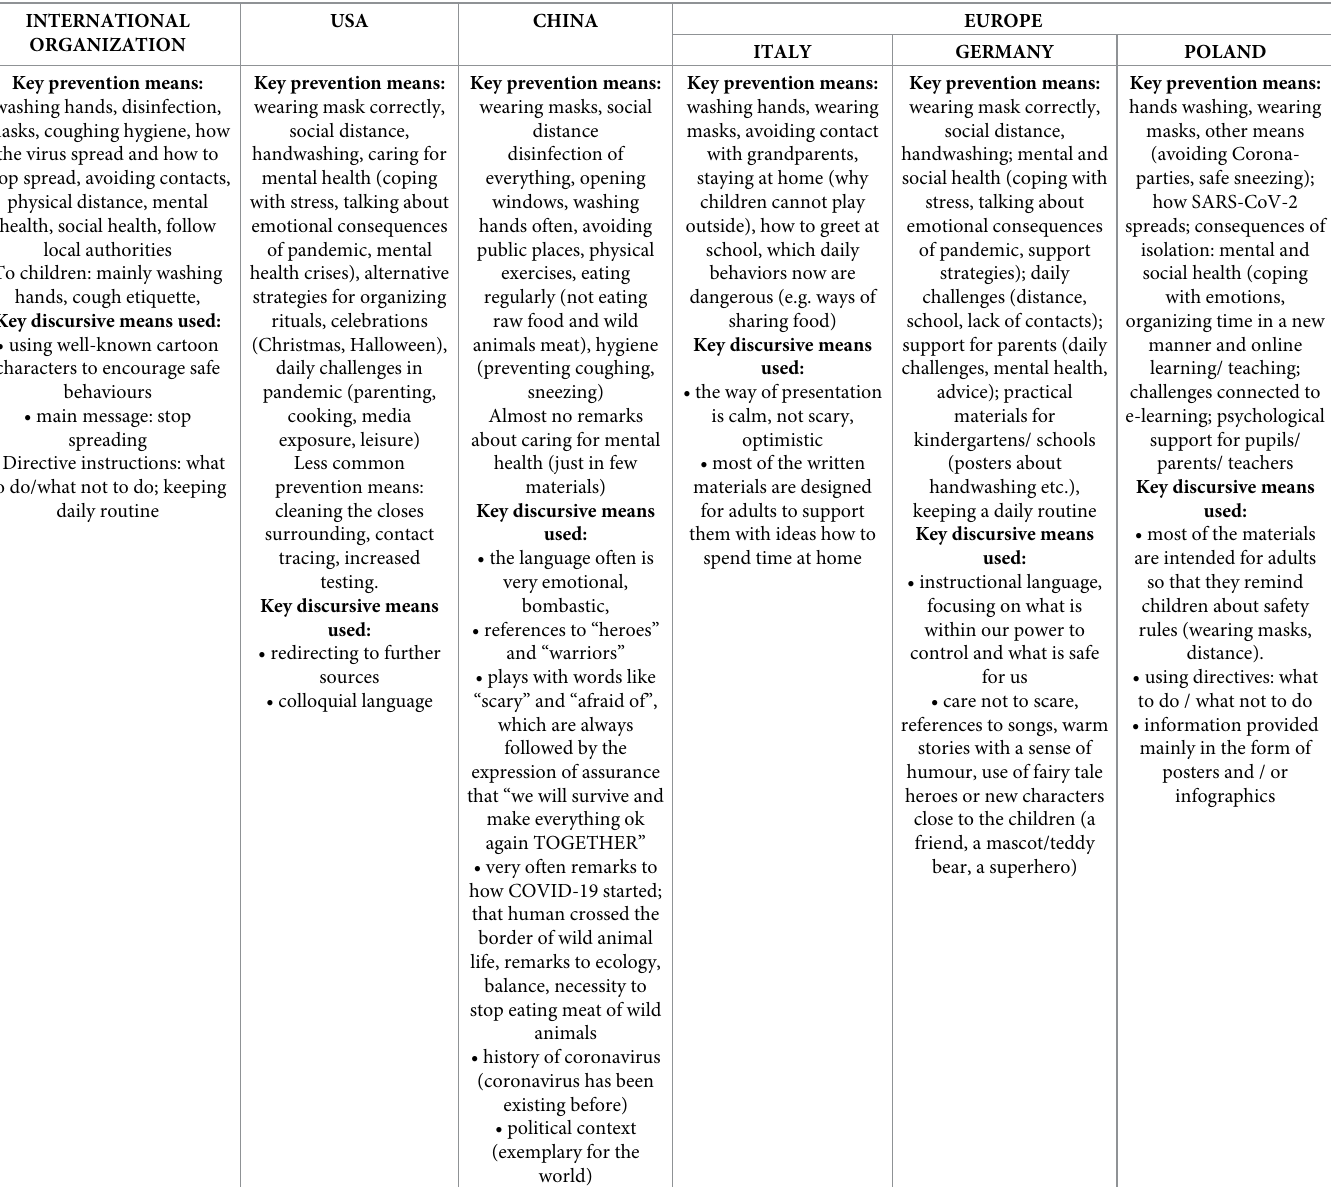
Table 2. International and national educational materials on COVID-19 pandemics - case